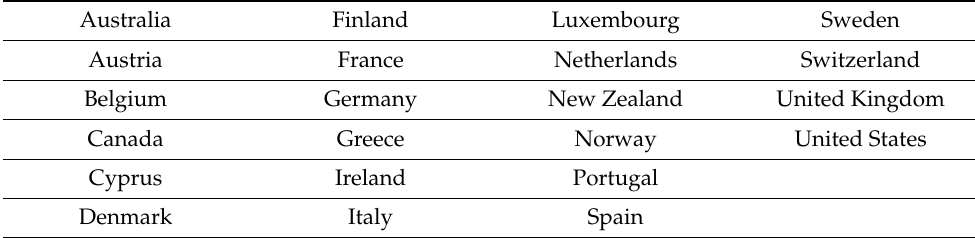
Table A1. Western Europe and North America (including Cyprus, Australia and New Zealand)—22 Countries.